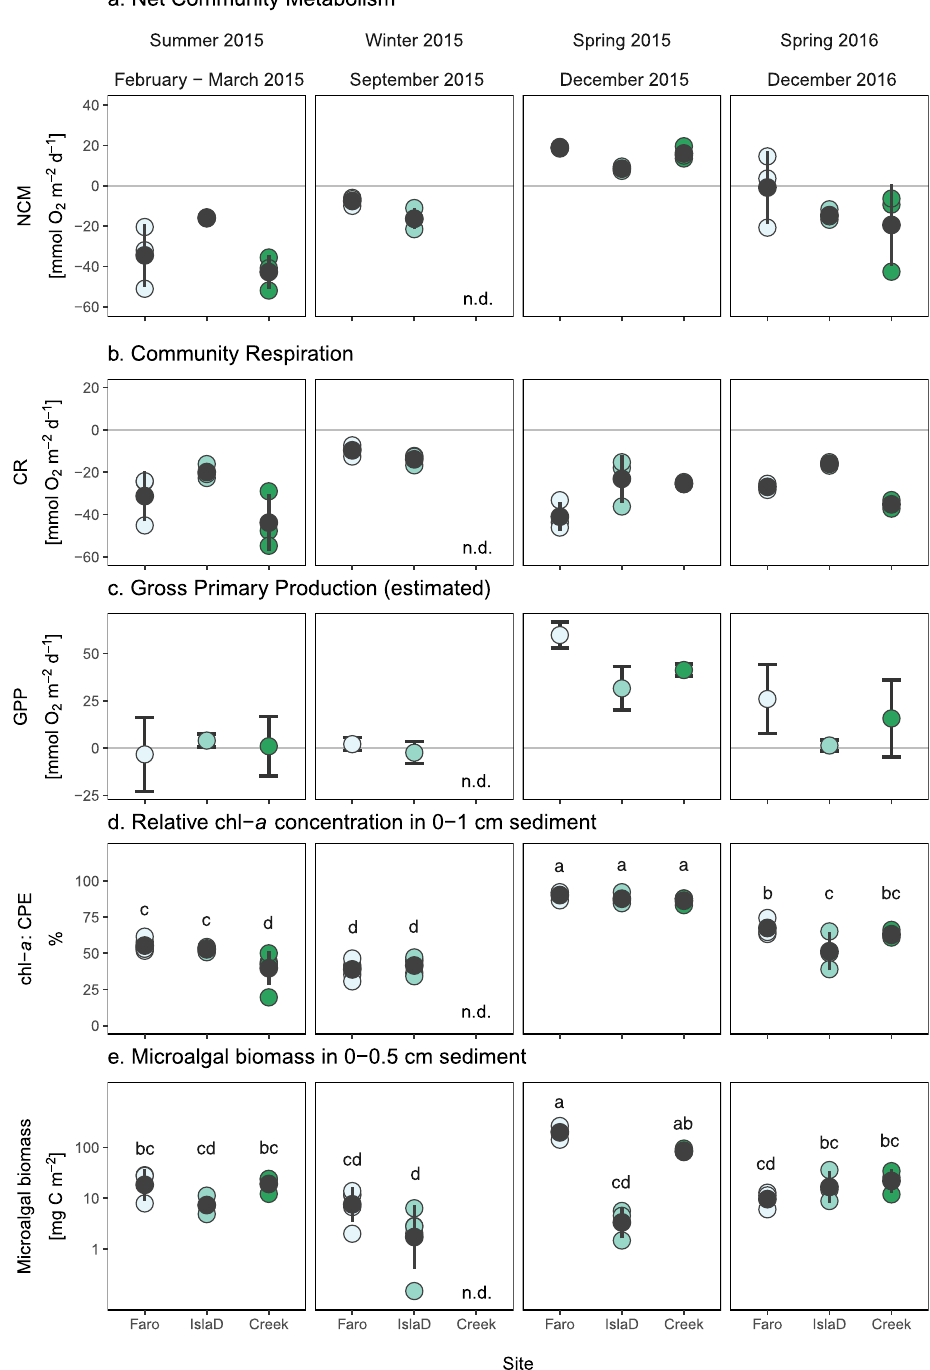
Fig. 3 Benthic metabolism parameters. Temporal variability in benthic parameters in the three investigated sites in terms of a Net community metabolism (NCM) measured in the transparent chambers ( n = 3, but see three omissions in the section “ Methods ” ), b community respiration (CR) measured in the dark chambers ( n = 3, but see two omissions in the section “ Methods ” ) and c calculated gross primary production (GPP) based on NCM and CR (see the section “ Methods ” ), d chlorophyll- a as a percentage of total chloroplastic pigment equivalents (CPE) in the upper 1 cm sediment ( n = 5 – 6 in summer and winter 2015 and n = 3 in spring 2015 and 2016) and e benthic microalgal biomass in the upper 0.5 cm sediment (on log 10 scale; n = 3, except for winter 2015 samples, where n = 5) in the three investigated sites. Individual measurements are shown as coloured points, while average ± s.d. is shown in black. Letters in d and e refer to statistical differences that are speci fi ed in Supplementary Table 2. Source data can be found in Supplementary Dataset 2.